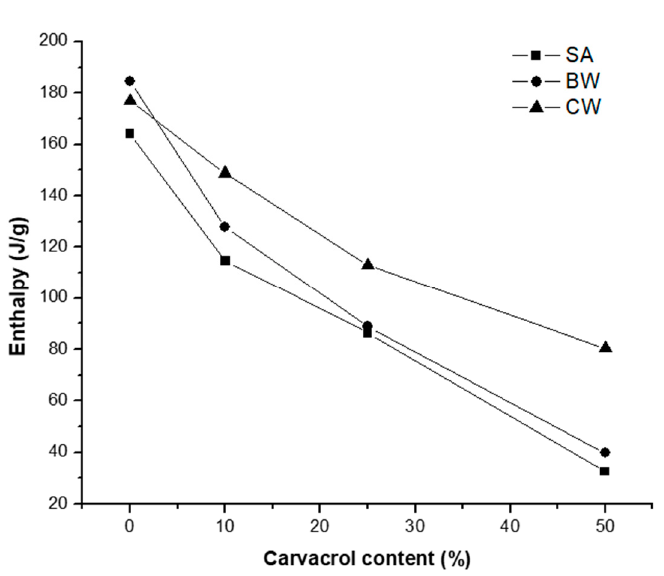
Figure 3. Variation of the enthalpy of stearic acid (SA), beeswax (BW) and carnauba wax (CW) with the increased concentration of carvacrol (%, w/w) in each binary mixture.